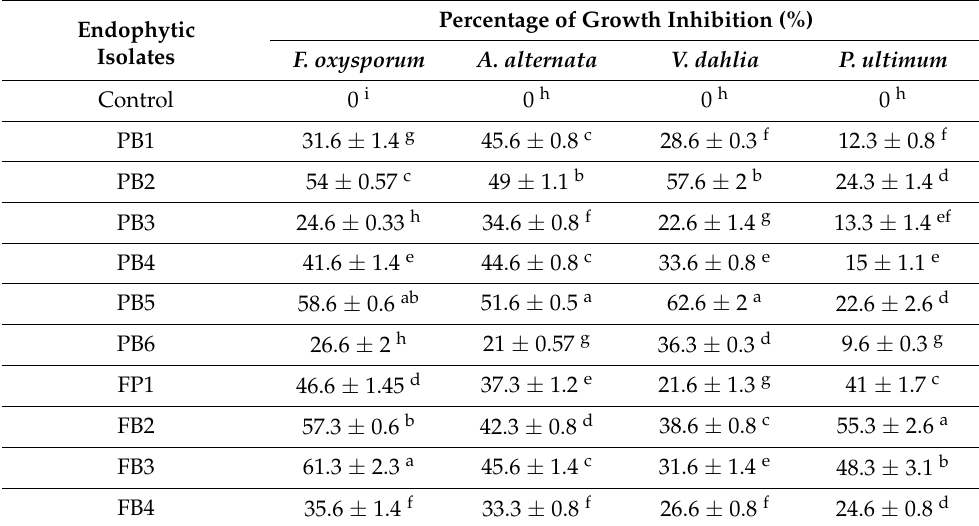
Table 2. The antagonistic activity of isolated endophytes against selected phytopathogenic